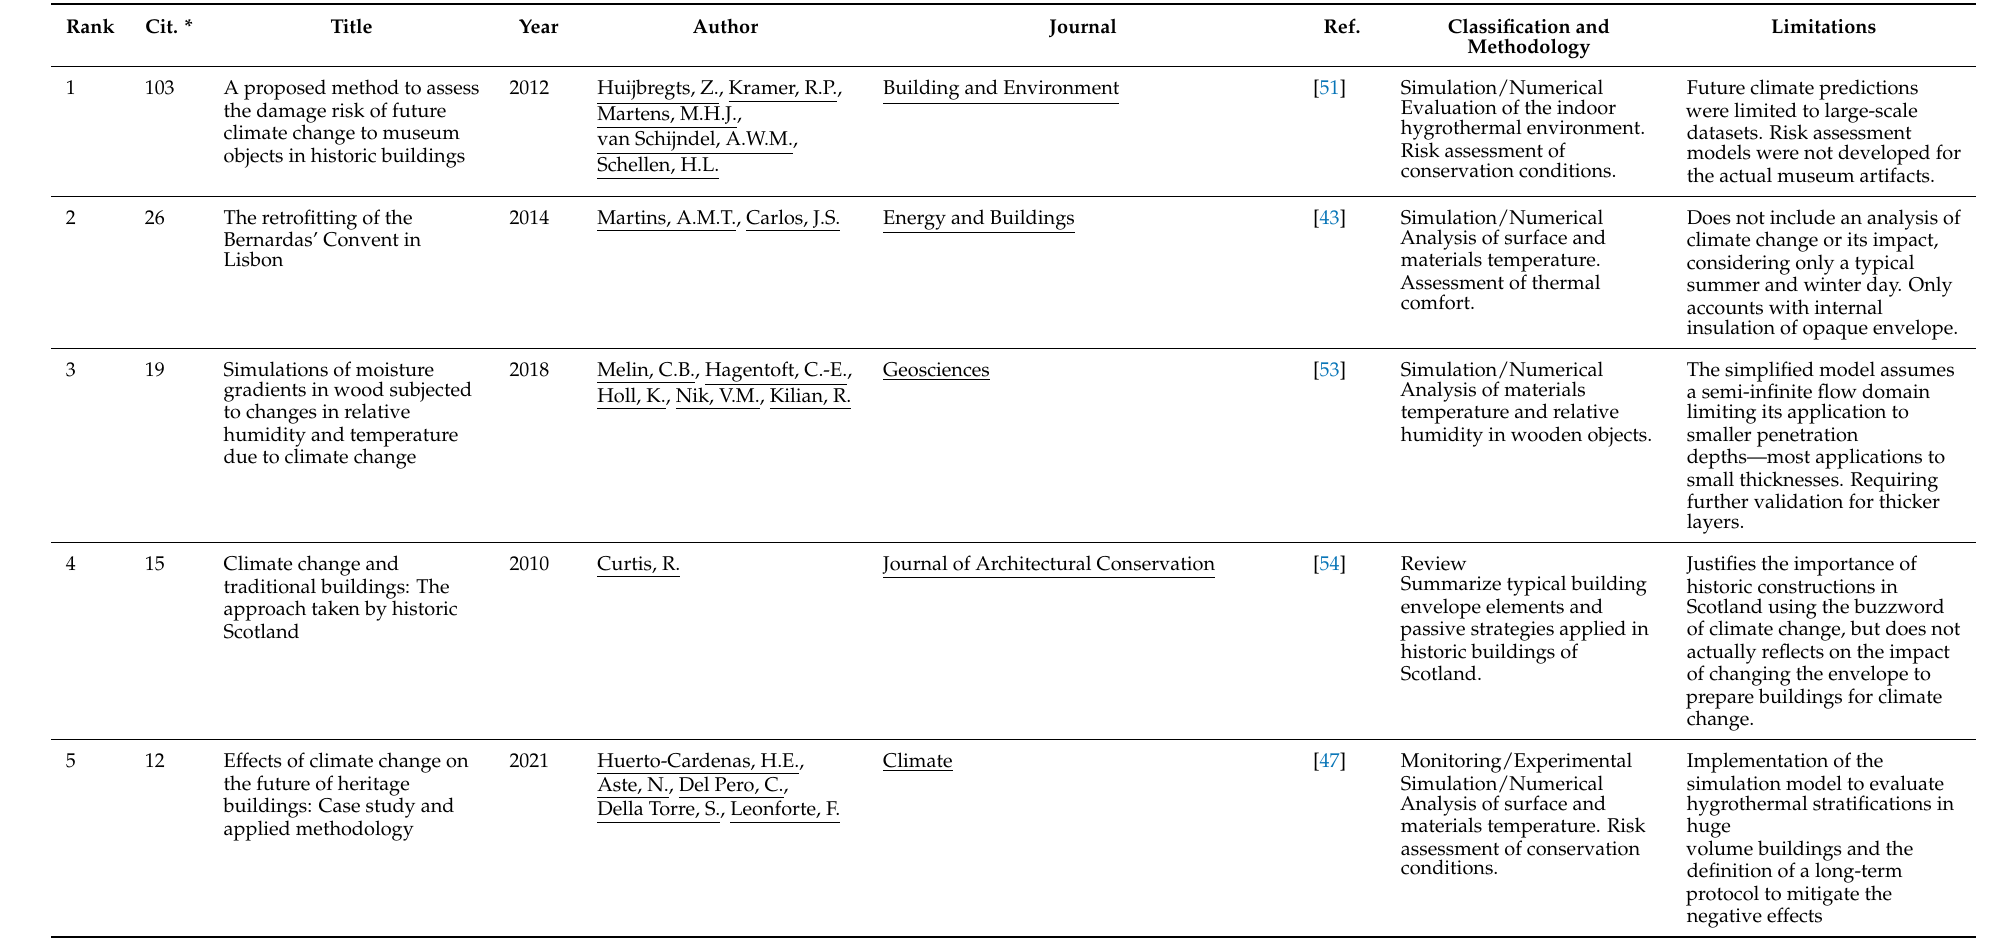
Table 4. Ten most cited papers on the